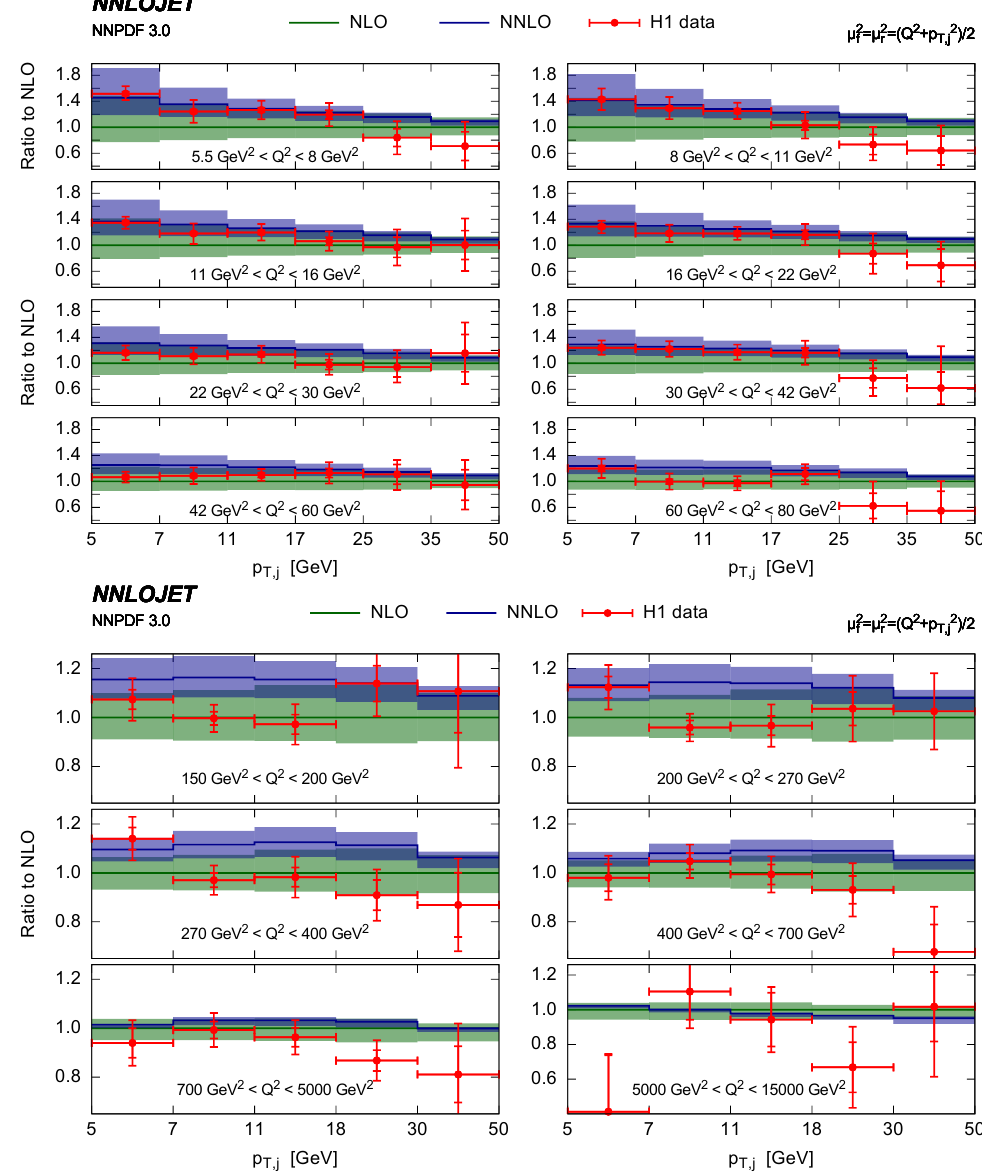
Figure 5 . Inclusive jet production cross section as a function of the jet transverse momentum p T;B in bins of Q 2 , compared to H1